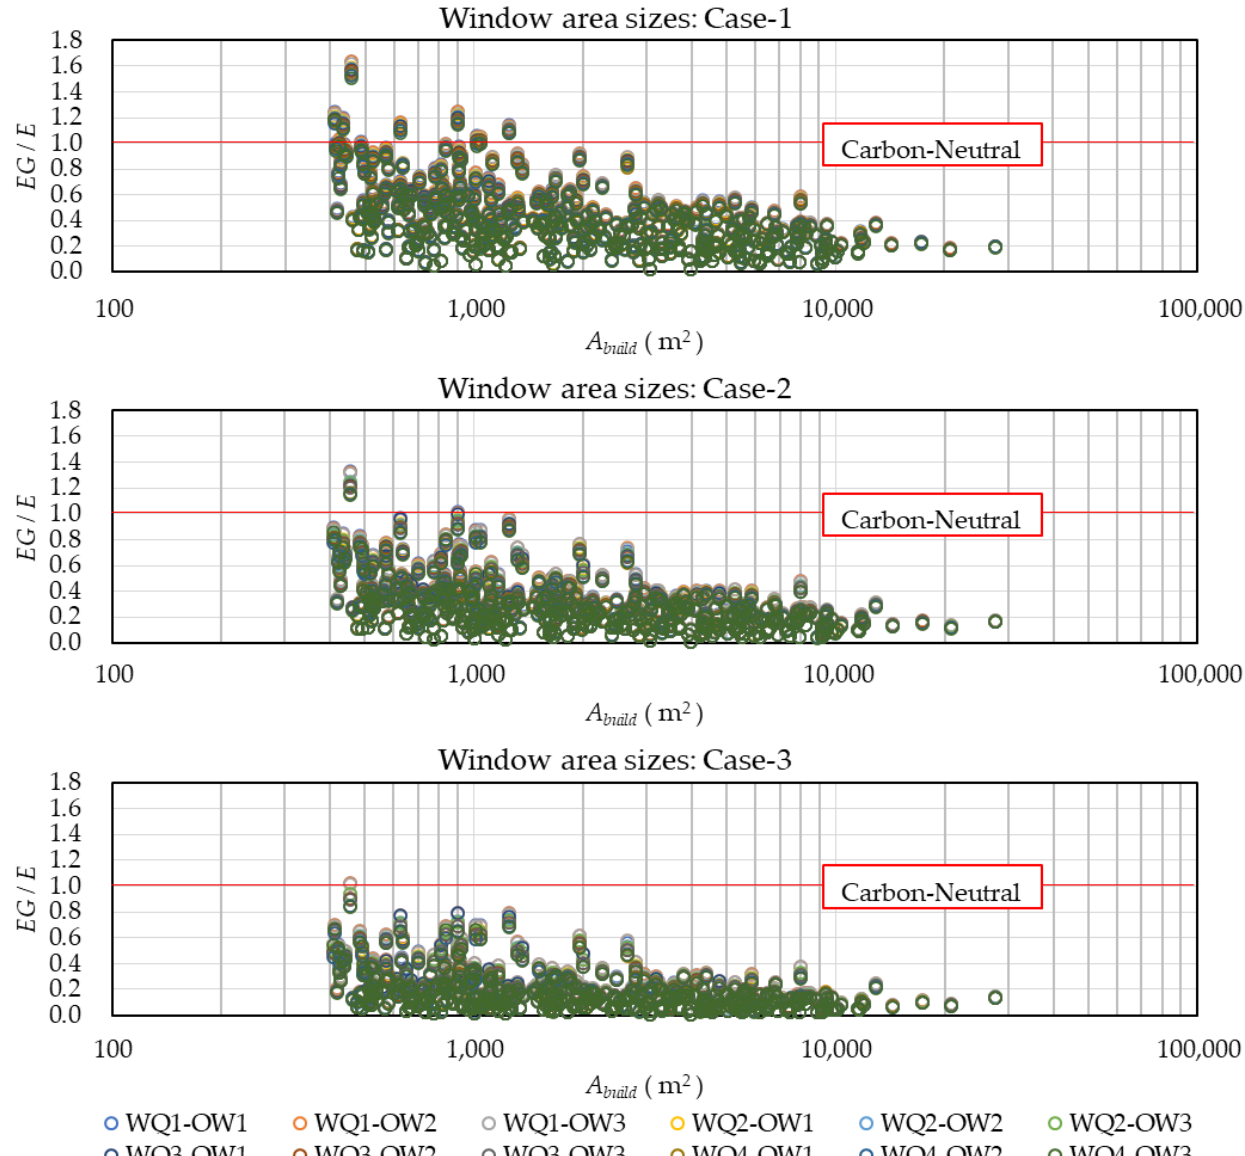
Figure 16. Scatter plots of 𝐸𝐺/𝐸 against the gross floor area ( 𝐴 𝑏𝑢𝑖𝑙𝑑 ).